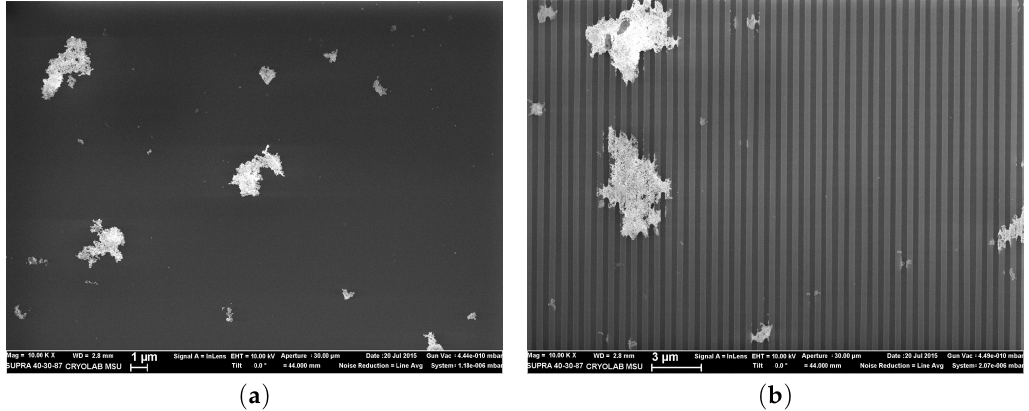
Figure 17. SEM images of AuNP-DTNB conjugates on: ( a ) flat and non-structured PMMA film; ( b ) PMMA bars; small bright spots are gold nanoparticles, some of them are organized in conglomerates, reprinted with permission from [16], the Optical Society